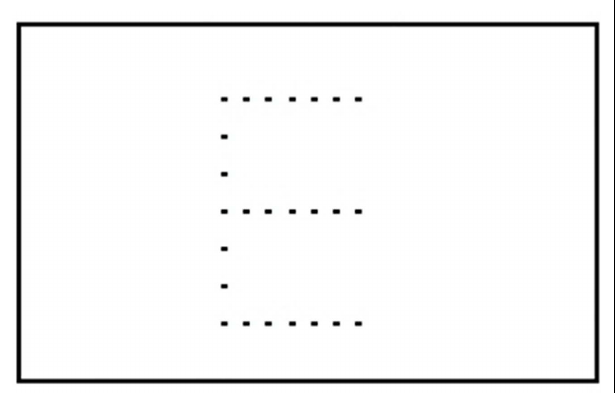
FIGURE 2 | Non-degraded stimulus.